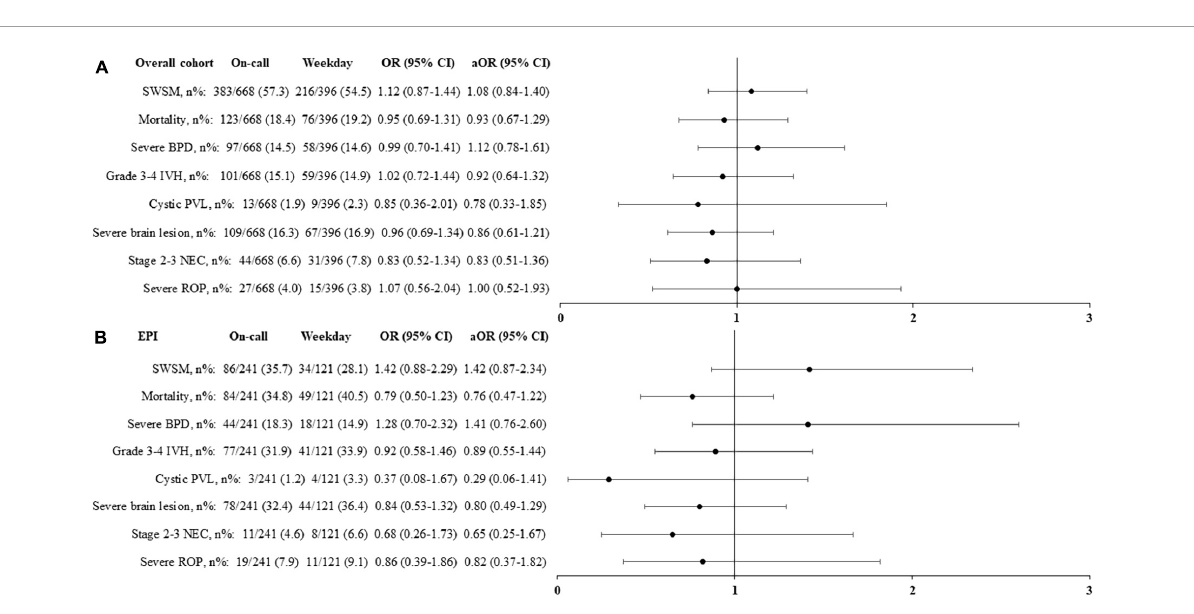
FIGURE2 Primary and secondary outcomes according to the period of birth in the overall population (A) and in extremely premature infants, born < 27 weeks’ gestational age (B) . Adjusted odds ratio (aOR), weighted by the propensity score, and their 95% confidence interval (95% CI) shown of the figure, are expressed vs. weekday. On-call: defined as birth in weekdays between 6.30 p.m. and 8.30 a.m., in weekends and public holidays. EPI, extremely premature infants; SWSM, survival without severe morbidity; BPD, bronchopulmonary dysplasia; IVH, intraventricular hemorrhage; PVL, periventricular leukomalacia; NEC, necrotizing enterocolitis; ROP, retinopathy of